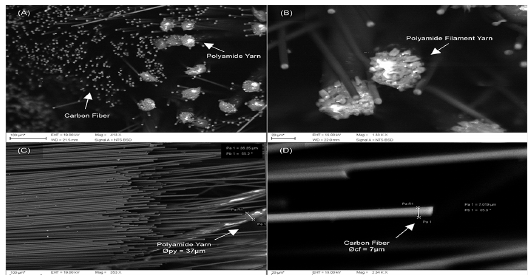
Figure 5. SEM images of CF/PA commingled tow. (A) Transversal section. (B) PA filament yarn detail. (C) Tow